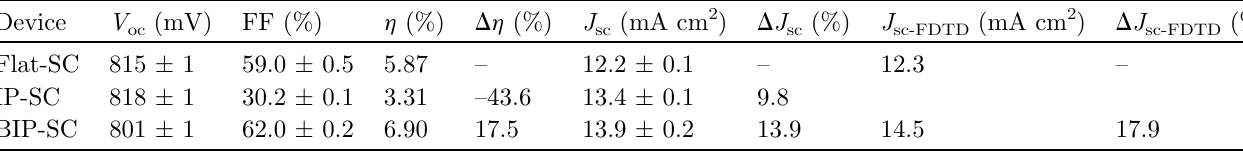
and h are calculated using D J sc (cid:1) h )/ h ] (cid:3) 100% respectively. IP(BIP)-SC Flat-SC Flat-SC